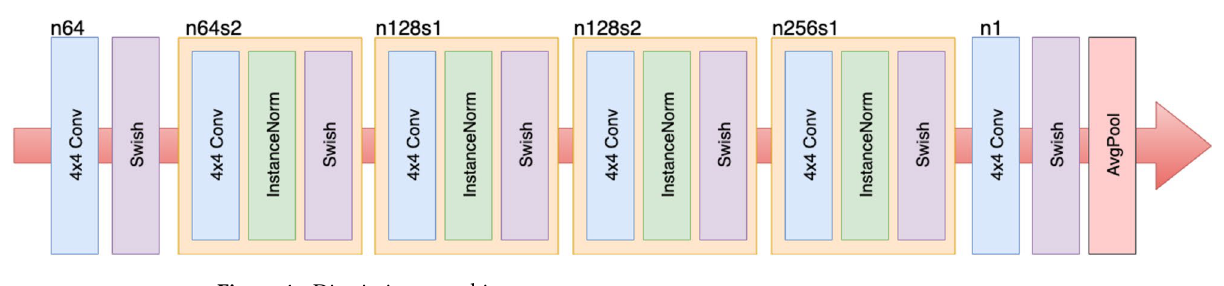
Figure 4. Discriminator